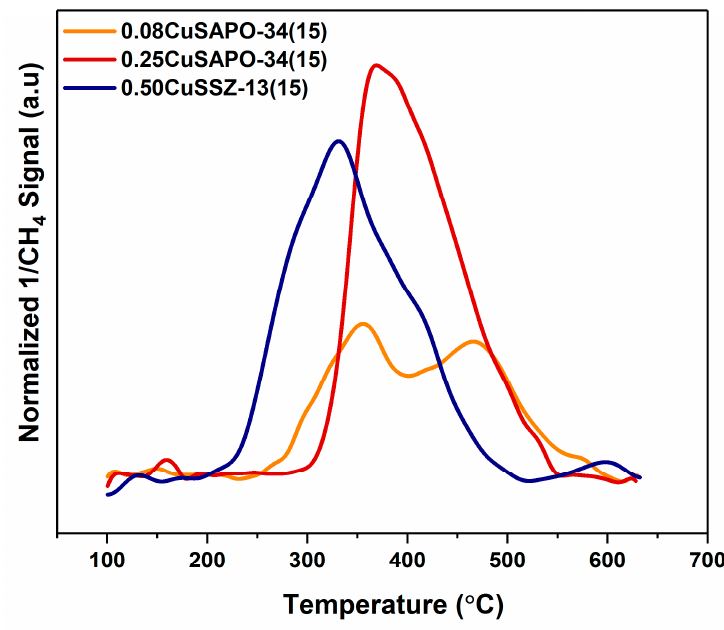
Figure 8. Inversed CH 4 consumption of 0.50CuSSZ-13 (blue), 0.08CuSAPO-34 (orange) and 0.25CuSAPO-34 (red) measured by an online MS during flow of CH 4 while heating from 100 to 650 °C (ramp: 5 °C/min). The materials were activated at 500 °C in O 2 for 8 h prior to the CH 4 -TPR experiment. The graphs have been normalized to the sample weight.